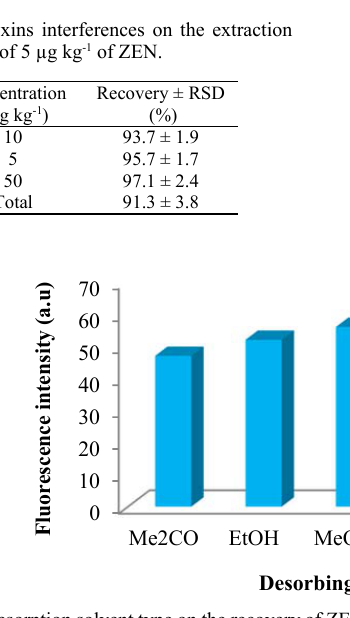
Fig. 8 Effect of desorption solvent type on the recovery of ZEN. Conditions: dispersive solvent volume and type, 3 mL of MeCN/water (80:20 v/v), extraction solvent, 320 µL of 1-octanol, water volume, 15 mL, equilibration time, 60 s, adsorbent amount, 50 mg; adsorption time, 3 min; desorption time, 4 min, desorption solvent volume, 1 mL.